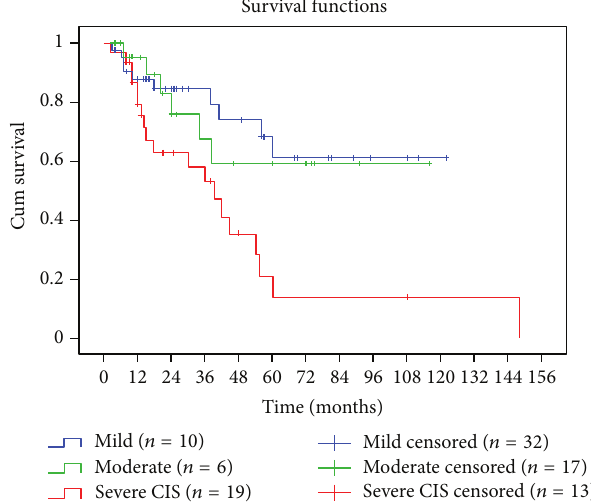
Figure 2: Kaplan-Meier analysis plotting disease-free survival according to high- and low-grade dysplasia ( 𝑃 = 0.013 , Log-Rank